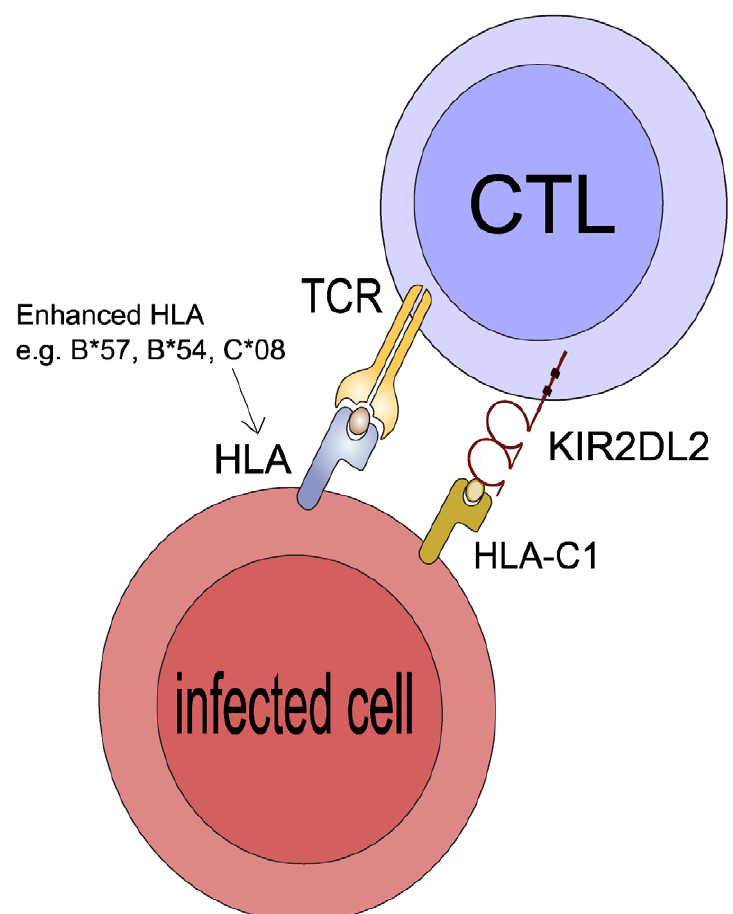
Figure 4. Postulated mechanism: KIR2DL2 reduces clonal exhaustion of CD8 + T cells and is necessary for an effective immune response in the face of chronic antigen stimulation. It has been demonstrated that CD8 + T cells that express inhibitory KIR have elevated levels of Bcl-2, are less susceptible to activation induced cell death (AICD) and have a survival advantage leading to their accumulation in vitro and in vivo [30,31]. We suggest KIR2DL2 binds its HLA-C ligands so that when the CD8 + T cell is activated by engagement of its TCR by the cognate HLA:peptide complex the CD8 + T cell will less likely to undergo AICD. If the CD8 + T cell is restricted by a protective HLA class I molecule (e.g. B*57 in HCV or C*08 in HTLV-1) it will survive for longer than in a person who is KIR2DL2- and its protective effects will be enhanced. Similarly, if the CD8 + T cell is restricted by a detrimental HLA molecule (e.g. B54 in HTLV-1) it will also survive for longer and its detrimental effects will be enhanced. Of note, the HLA molecule whose protective/detrimental effects are enhanced is the HLA molecule that binds the TCR not the HLA that binds KIR2DL2. This postulated mechanism explains 3 striking features of our observations: i) that KIR2DL2, a receptor typically associated with innate immunity, enhances adaptive immunity ii) that the effect cannot be explained by KIR2DL2 binding the enhanced HLA molecules directly iii) that both protective and detrimental HLA effects are enhanced.